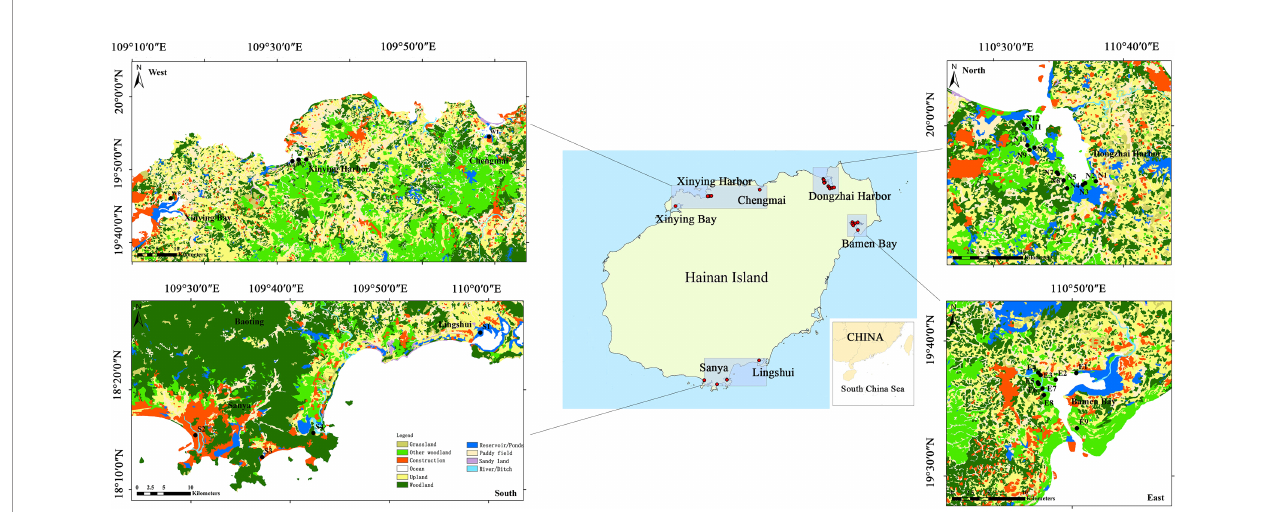
FIGURE 1 | Land use map for mangrove wetlands with the sediment sample locations on Hainan Island in China. Note: mangrove areas are included in the other